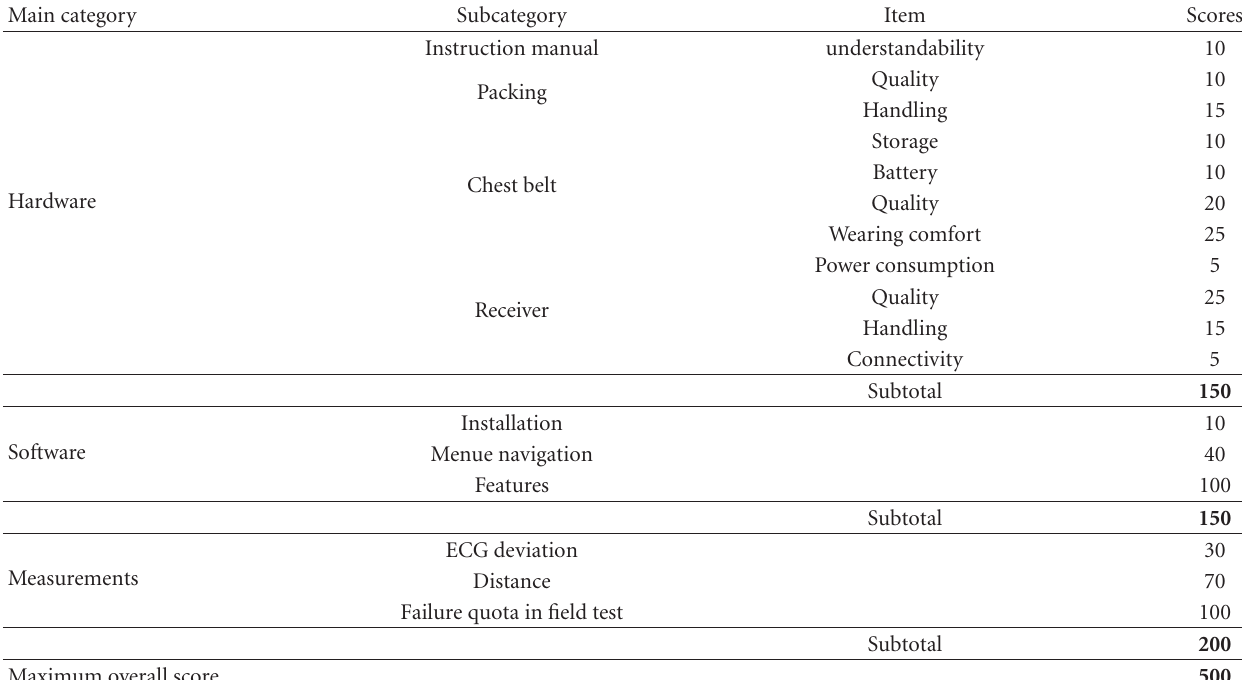
Table 1: 500-score quality rating system, overall rating system divided in three main categories: hardware, software, and